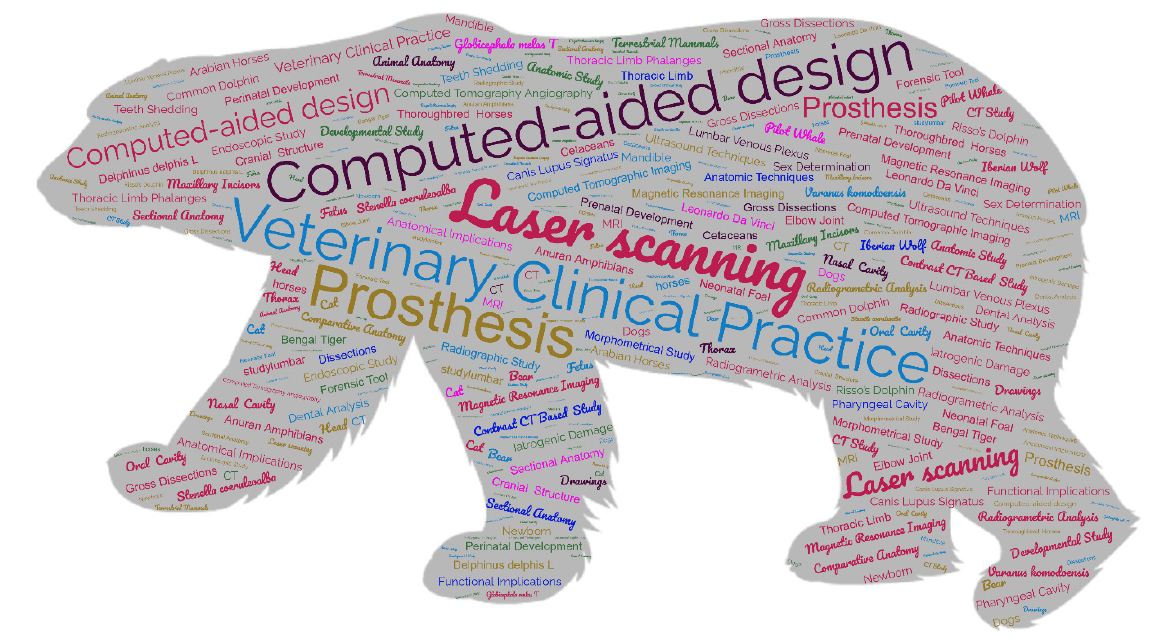
Figure 1. A tag cloud including the titles and keywords of the articles published in this Special Issue.